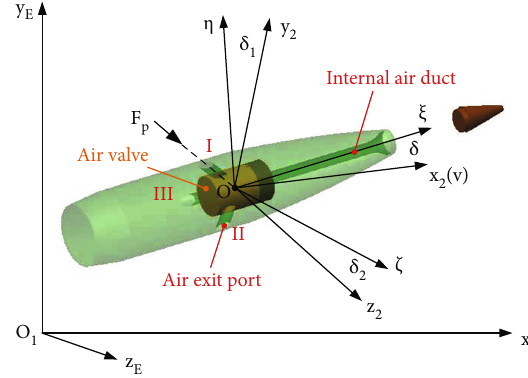
Figure 2: Projectile structure schematic for the corrected con fi guration and projectile ’ s position de fi